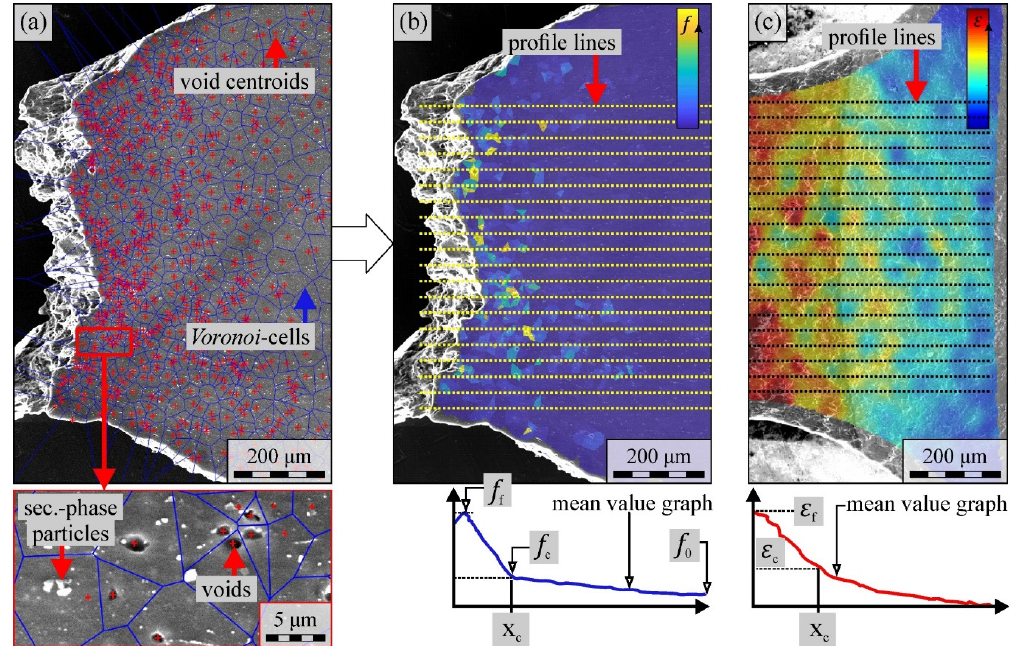
Figure 2. Voronoi decomposition method to calculate the local void area fraction by ( a ) partitioning the cross-section images and ( b ) relating the individual region areas to the void area contained therein; ( c ) example of digital image correlation (DIC) strain analysis carried out using images of the specimen surface.